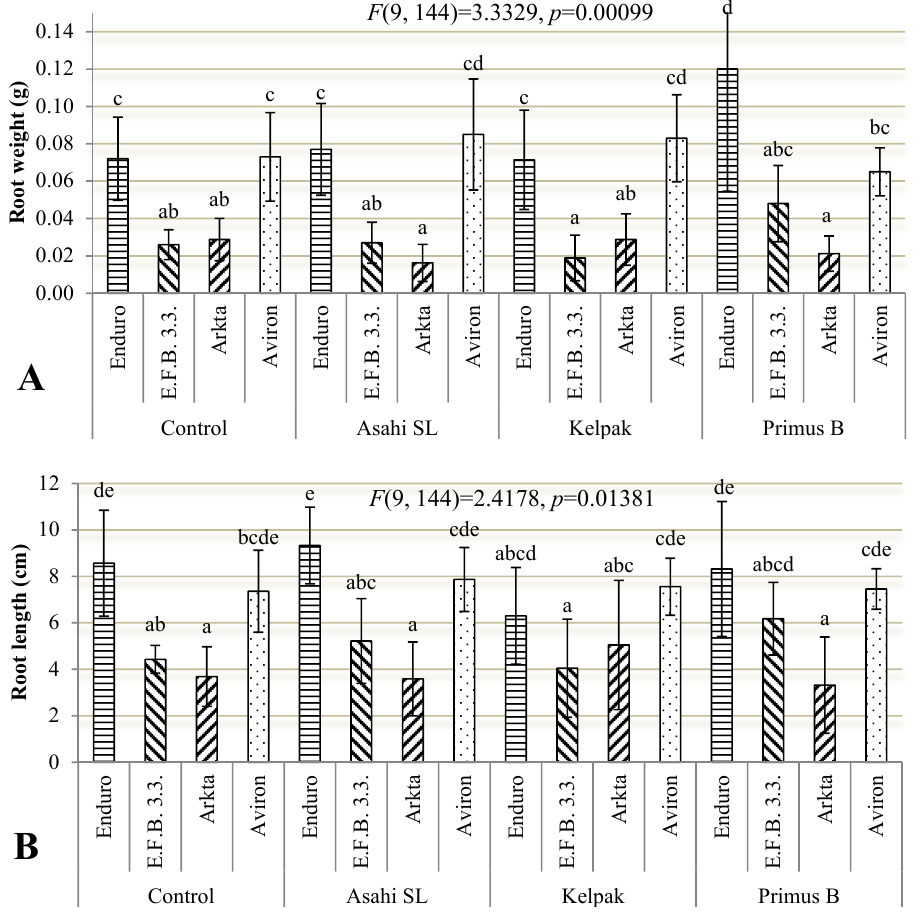
Fig. 1 The interaction of the cultivars and biostimulators in the assessment of the ( A ) weight (g) and ( B ) length (cm) of roots of winter pea seedlings. Different letters indicate differences between means significant at p < 0.05 according to Tukey’s HSD